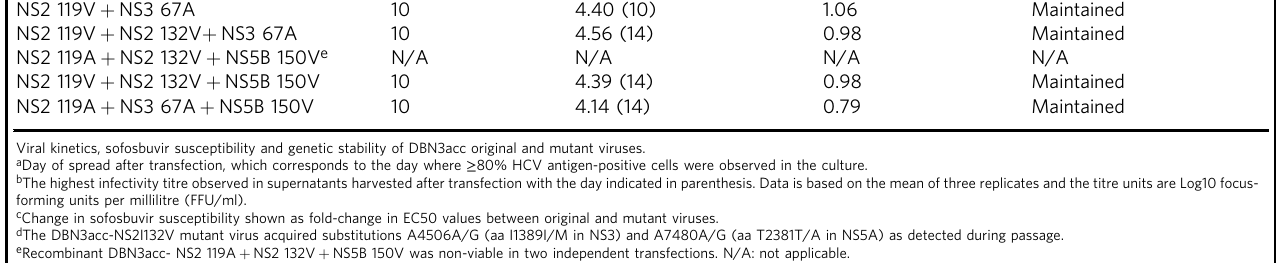
Viral kinetics, sofosbuvir susceptibility and genetic stability of DBN3acc original and mutant viruses. a Day of spread after transfection, which corresponds to the day where ≥ 80% HCV antigen-positive cells were observed in the culture. b Thehighest infectivitytitreobserved insupernatants harvestedaftertransfection withthe dayindicatedin parenthesis. Data isbased onthe meanof threereplicates and thetitre unitsare Log10focus- forming units per millilitre (FFU/ml). c Change in sofosbuvir susceptibility shown as fold-change in EC50 values between original and mutant viruses. d The DBN3acc-NS2I132V mutant virus acquired substitutions A4506A/G (aa I1389I/M in NS3) and A7480A/G (aa T2381T/A in NS5A) as detected during passage.